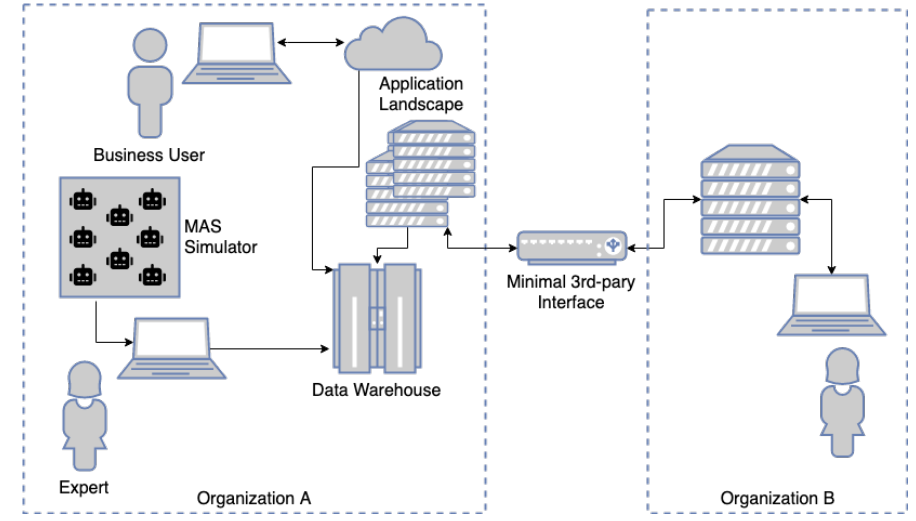
Figure 3. Stand-alone ABS, minimal organizational